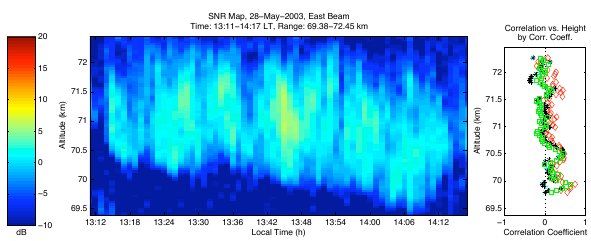
Fig. 8. A multi-blob layer centered at 71 km on May 28 at 13:10 LT.